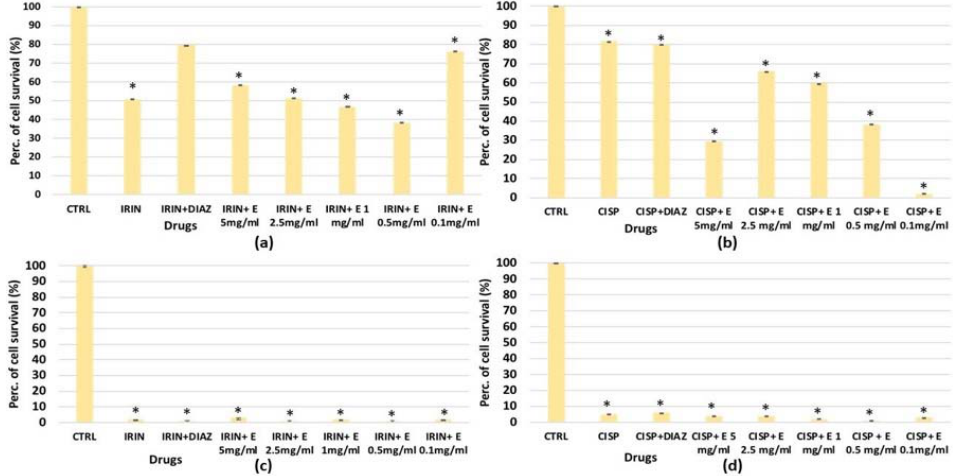
agents (Figure 8c,d).